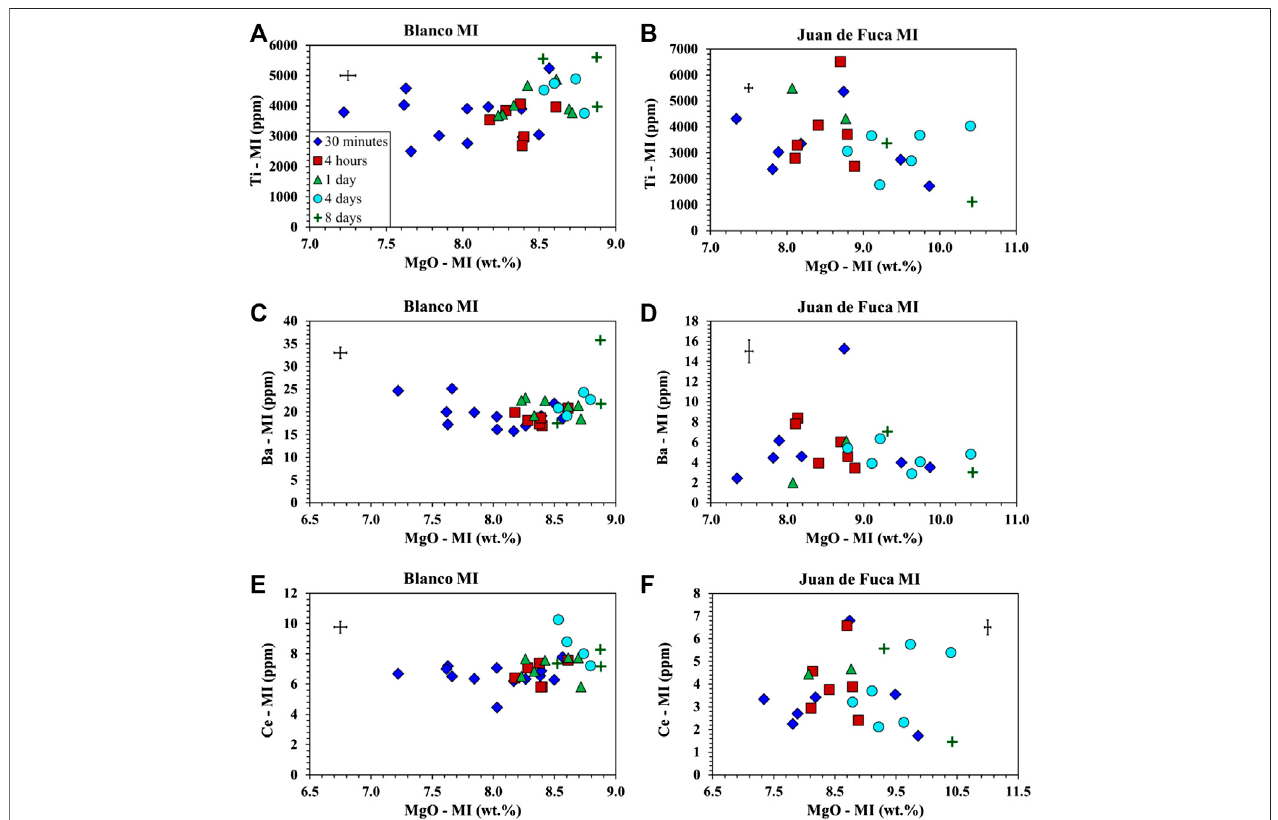
FIGURE 5 | Trace element analysis of MI obtained by LA-ICP-MS following homogenization at 1 bar for samples from the Juan de Fuca Ridge (D23-2) and the BlancoFractureZone(A91-1R1).Symbolsasin Figure1 .Errorbarsarelocatedintheupperleftorrightcornerofeachplot. (A) Tivs.MgOforA91-1R1(BlancoFracture Zone)showsanincreaseinTiandanincreaseinMgOwithtime. (B) Tivs.MgOforD23-2(JuandeFuca)showsadecreaseinTiandanincreaseinMgOwithtime. (C) Ba vs. MgO forA91-1R1 (Blanco Fracture Zone) showsno trendinBaand anincrease inMgO. (D) Bavs. MgOforD23-2(Juan deFuca) shows notrend inBaand an increase in MgO. (E) Ce vs. MgO for A91-1R1 (Blanco Fracture Zone) shows a slight increase in Ce and an increase in MgO. (F) Ce vs. MgO for D23-2 (Juan de Fuca) shows no trend in Ce and an increase in